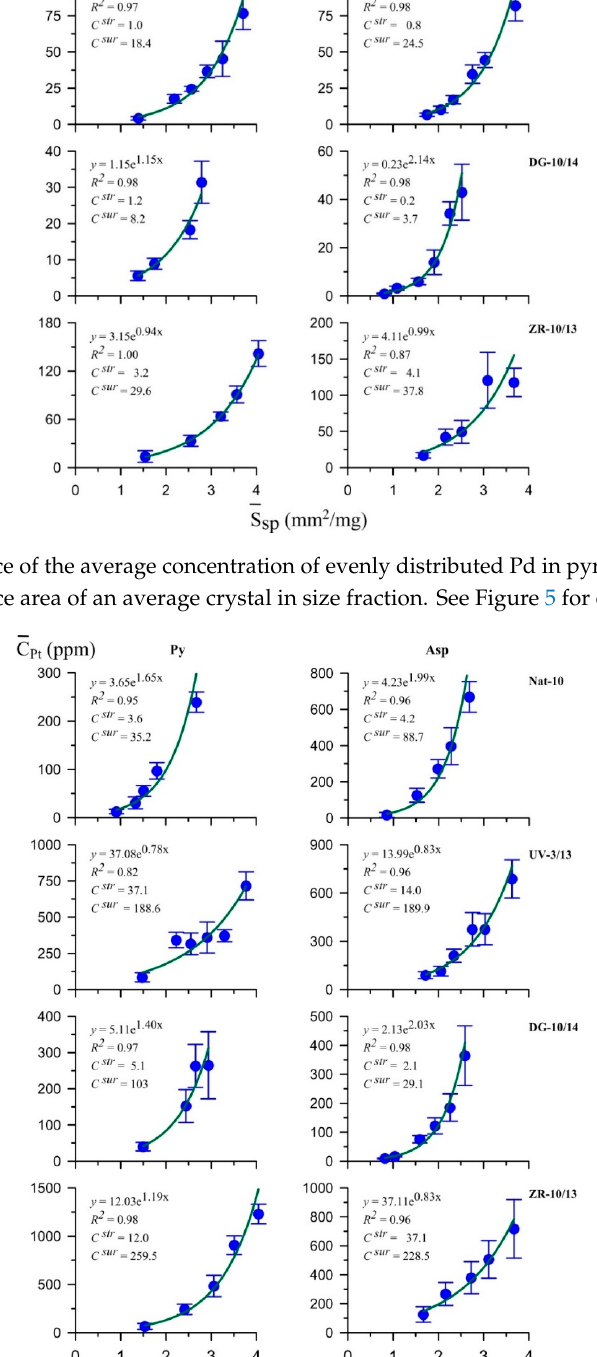
Figure 7. Dependence of the average concentration of evenly distributed Pt in pyrite and arsenopyrite on the specific surface area of an average crystal in size fraction. See Figure 5 for